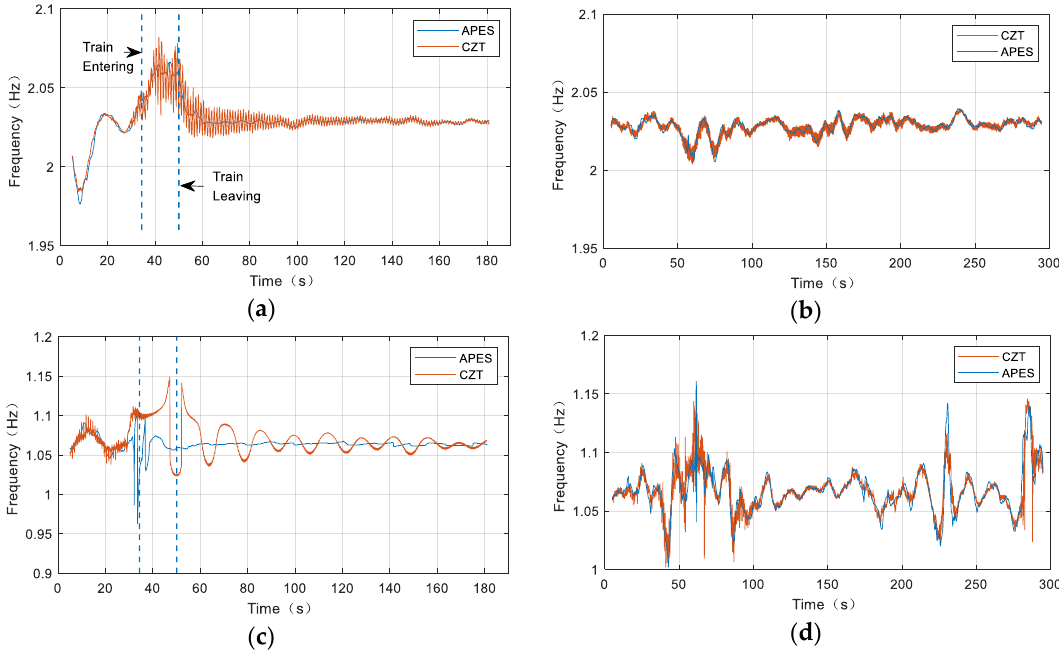
Figure 11. Fundamental frequency curves extracted from the time-frequency distribution images. The blue curve and the red curve are results of the CZT and the APES method, respectively. Dynamic fundamental frequency of the shortest cable with the passing train ( a ) and without load ( b ). Dynamic fundamental frequency of the longest cable with the passing train ( c ) and without load ( d ).